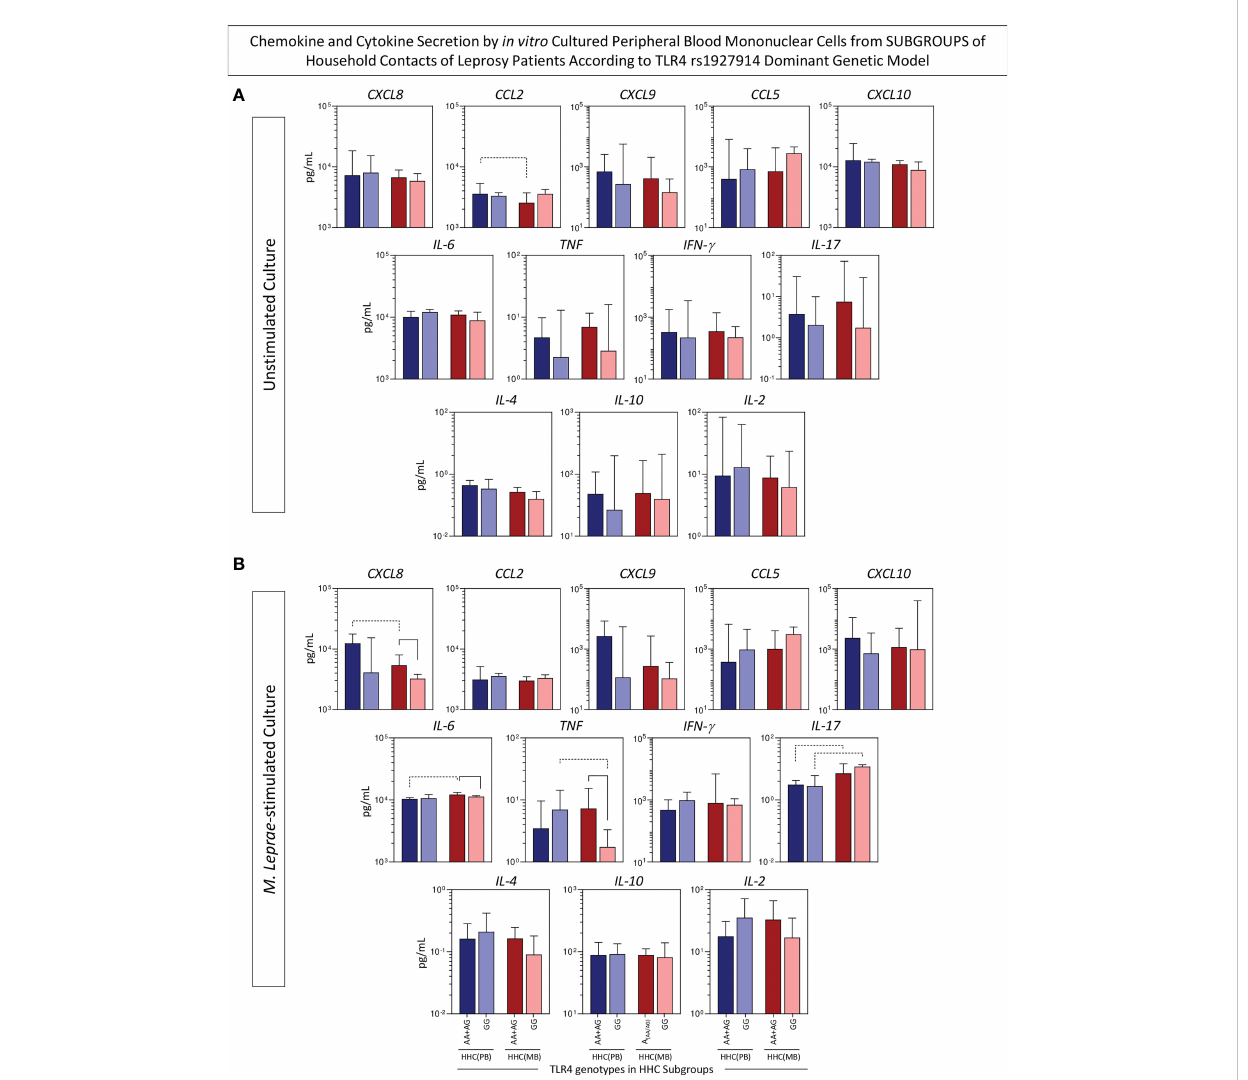
FIGURE 6 Chemokine and cytokine secretion by in vitro cultured peripheral blood mononuclear cells from subgroups of household contacts of leprosy patients according to the TLR4 rs1927914 dominant genetic model. The levels of chemokines (CXCL8, CCL2, CXCL9, CCL5, CXCL10) and cytokines (IL-6, TNF, IFN- g , IL-17, IL-4, IL-10 and IL-2) were measured in the supernatant collected upon in vitro culture of PBMC from household contacts of paucibacillary [HHC(PB), n =10] and multibacilary patients [HHC(MB), n = 23], further categorized according to the TLR4 rs1927914 genotype dominance model, as follows: AA+AG ( , n = 5; , n = 18, respectively) and GG ( , n = 5; , n = 5, respectively).Data were obtained (A) in the absence of exogenous stimuli (unstimulated culture) and (B) in the presence of M. leprae antigen stimulation (M. leprae-stimulated culture). Quantitative analysis was performed by Cytometric Beads Array (CBA) according to manufacturer instructions. The results are expressed in pg/mL and presented in bar chats, indicating the median values (25 th and 75 th interquartile range). Comparative analysis amongst subgroups was carried out by Kruskal-Wallis followed by Dunn ’ s post-test for multiple comparison between subgroups. Signi fi cant differences at p<0.05 are indicated by continuous and dashed connecting lines for intragroup and intergroup comparisons,